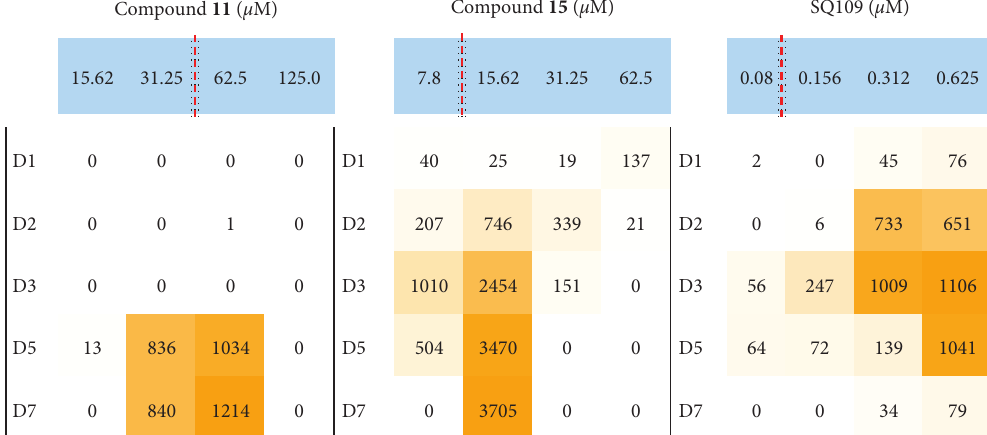
Figure 2: Observed luminescence data of compounds 11 , 15 , and SQ109 depicting cell wall damage over 7 days (D1–D7) at various concentration ranges ( μ M) spanning the MIC 90 (as indicated by the red dotted